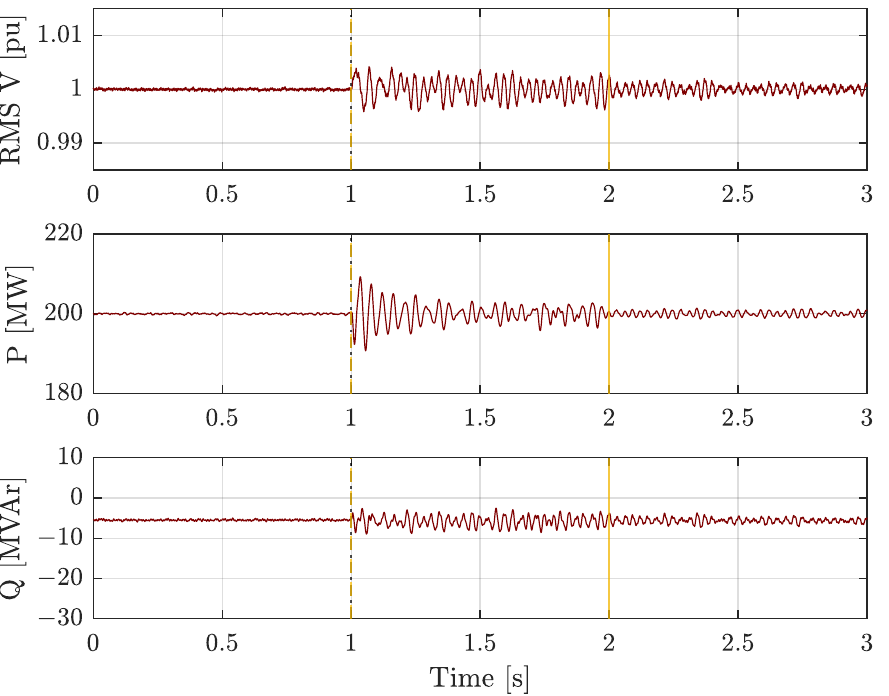
Figure 9. RMS voltage, real power, and reactive power waveforms with access to external signal. (black dashed line is when Line #2 trips, yellow dashed line is when SSCI is detected, and yellow straight line is when a stable operating point is